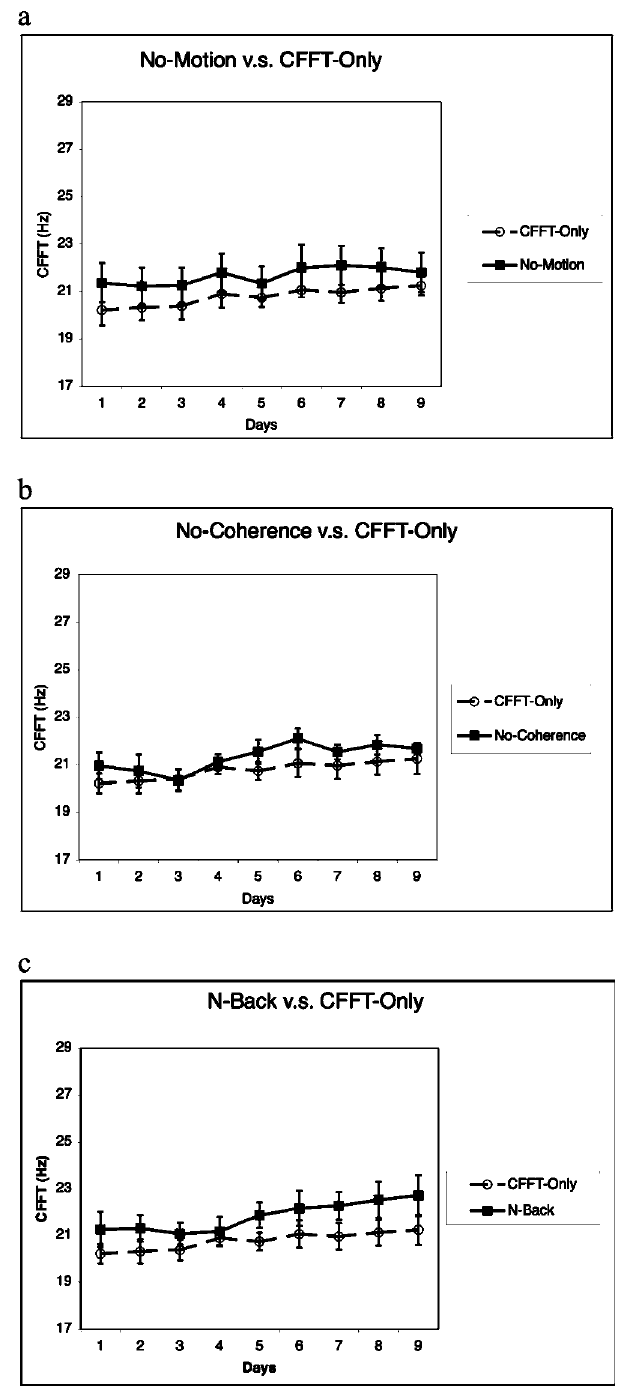
Figure 4. CFFT changes for control groups. a, CFFT is shown for each day for the No-Motion Group (solid-line) and the Flicker-Only Group (dashed-line). b, CFFT is shown for each day for the No-Coherence Group (solid-line) and the Flicker-Only Group (dashed-line). a, CFFT is shown for each day for the N-Back Group (solid-line) and the Flicker- Only Group (dashed-line). Error bars reflect standard-error.